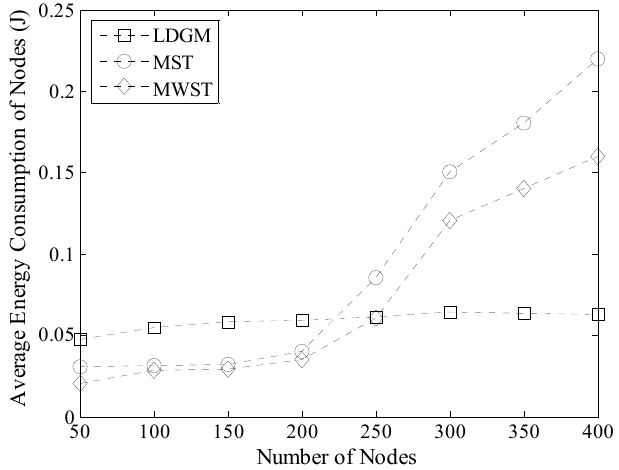
Figure 31. Average energy consumption of nodes (100 m × 100 m, 200 nodes).